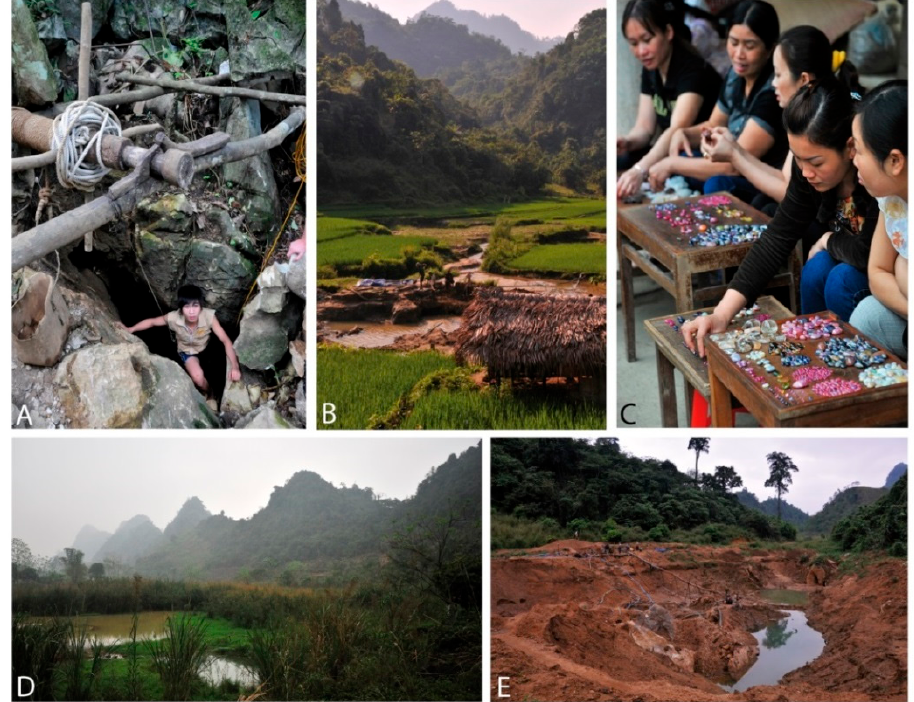
Figure 58. Ruby-bearing placers hosted in marble from northern Vietnam (Luc Yen area; 2009). ( A ) Exploitation by locals of ruby-bearing gravel concentration in karst pockets; ( B ) artisanal exploitation of ruby-bearing alluvial fans concentrated in narrow valleys bordered by rice fields; ( C ) the famous gem market at Luc Yen city; authorization for the photograph of the Luc Yen market by filed gemmologist M. Shuan, and ( D ) the gem-bearing valleys are often narrow and correspond to small depressions, which typically range in area from 2 to 3 km 2 . These valleys are defined by shear zones and faults that crosscut the marble units. The karst geomorphology is characterized by an alignment of marble domes forming cones and lines of karst hills; ( E ) excavation of ruby-bearing areas continued up to the marble pinnacles, but the missed gem areas between the pinnacles is exploited by locals with shovels, picks and buckets. Photos: Vincent Pardieu © GIA.